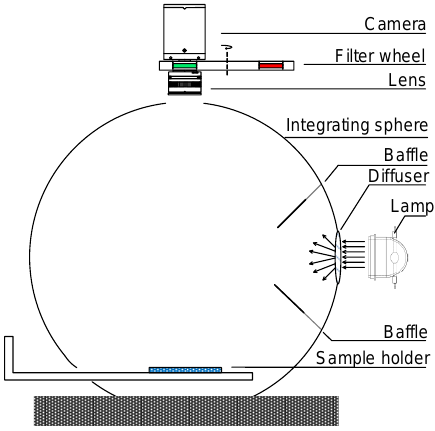
Figure 1. The schematic drawing of a typical integrating sphere multispectral imaging